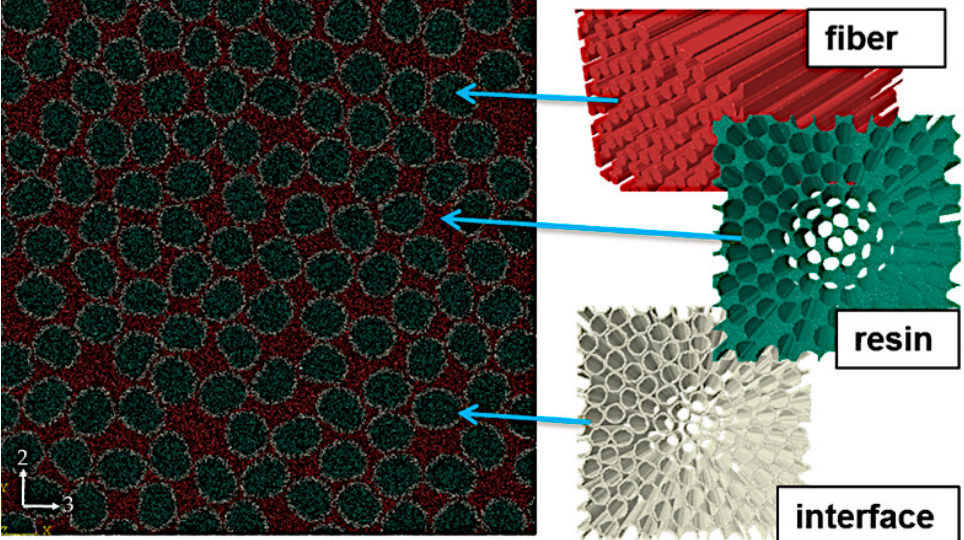
Figure 2. Representation of the three-phase microstructure: algorithmically detached fibers, interface (interphase) added to the fiber perimeters and resin filling the rest.